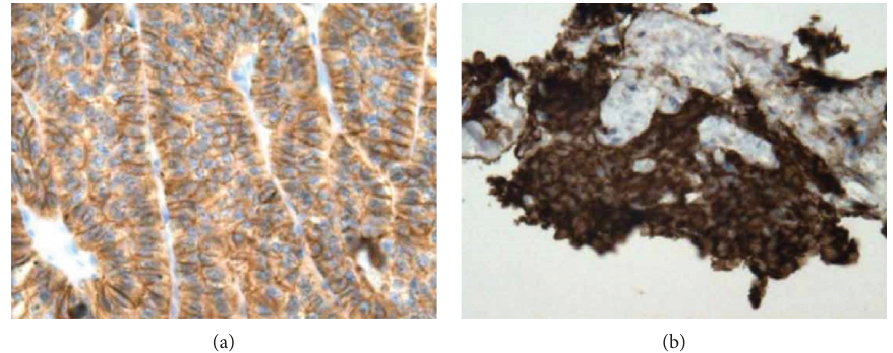
Figure 4: Immunohistochemical analysis demonstrates immunoreactivity for somatostatin receptor 2 antibody immunostaining in most tumor cells in the lung (a) and liver